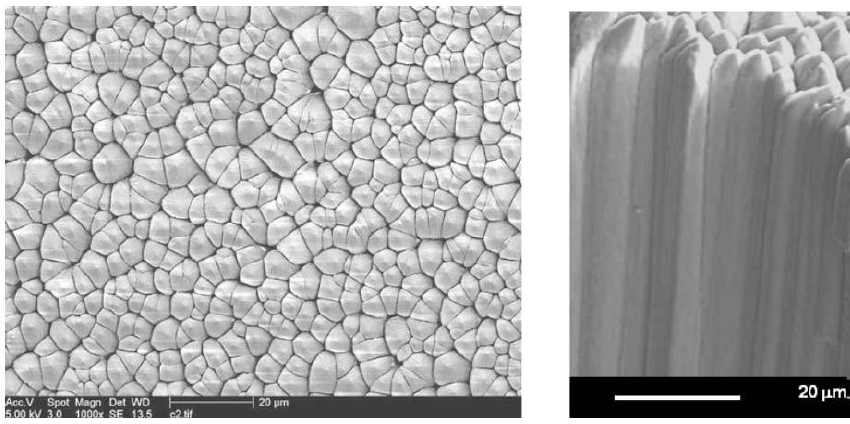
Figure 20. Top and side SEM images of a needle crystalline phosphor